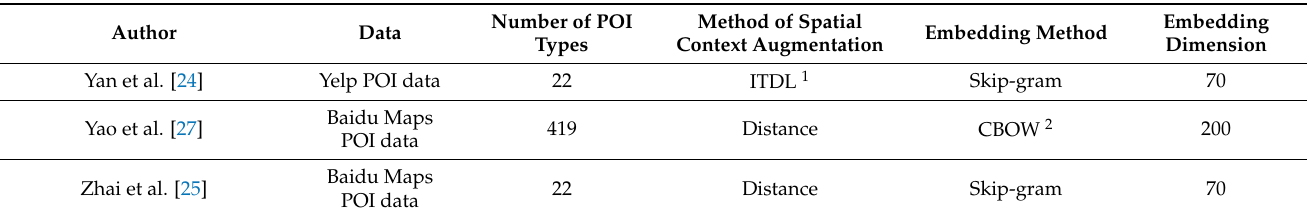
Table 2. Previous studies related to POI